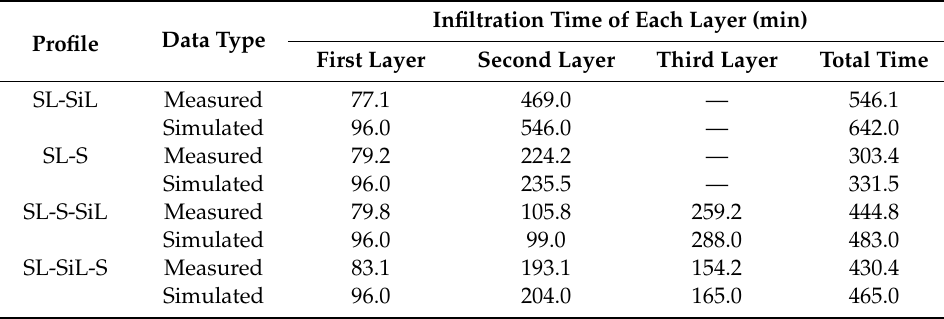
Table 6. The penetration times of the wetting front through the soil profiles.